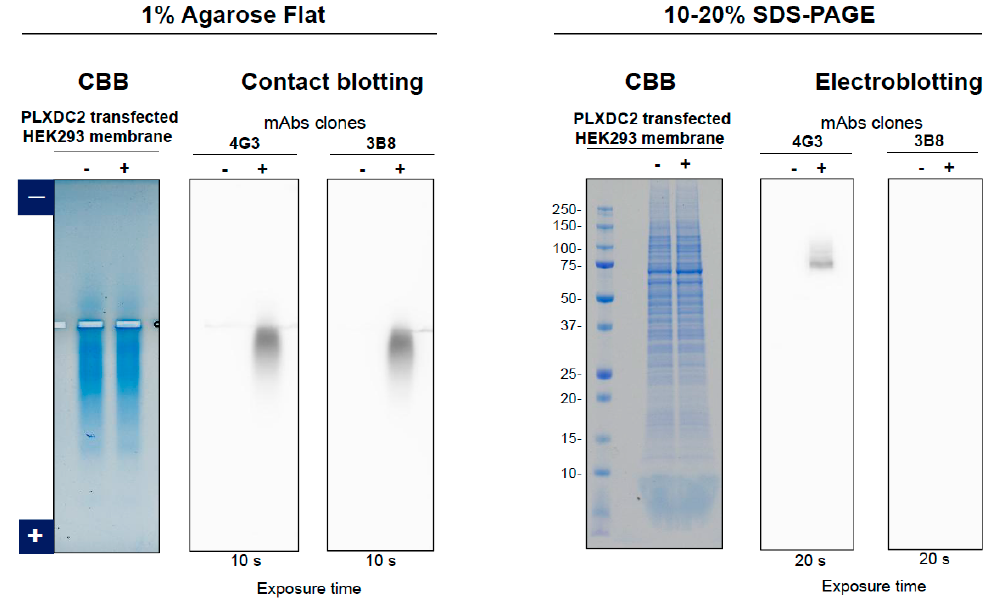
Figure 14. Comparison of contact blotting of agarose gel and electroblotting of SDS gel using PLXDC2 antigen. Left panel, 1% agarose gel and contact blotting. Right panel, SDS-polyacrylamide gel and electroblotting (semi-dry condition). For detection of human PLXDC2 protein, antibody 4G3 and 3B8 were used on both blots of agarose gel contact blotting and SDS polyacrylamide gel electroblotting.